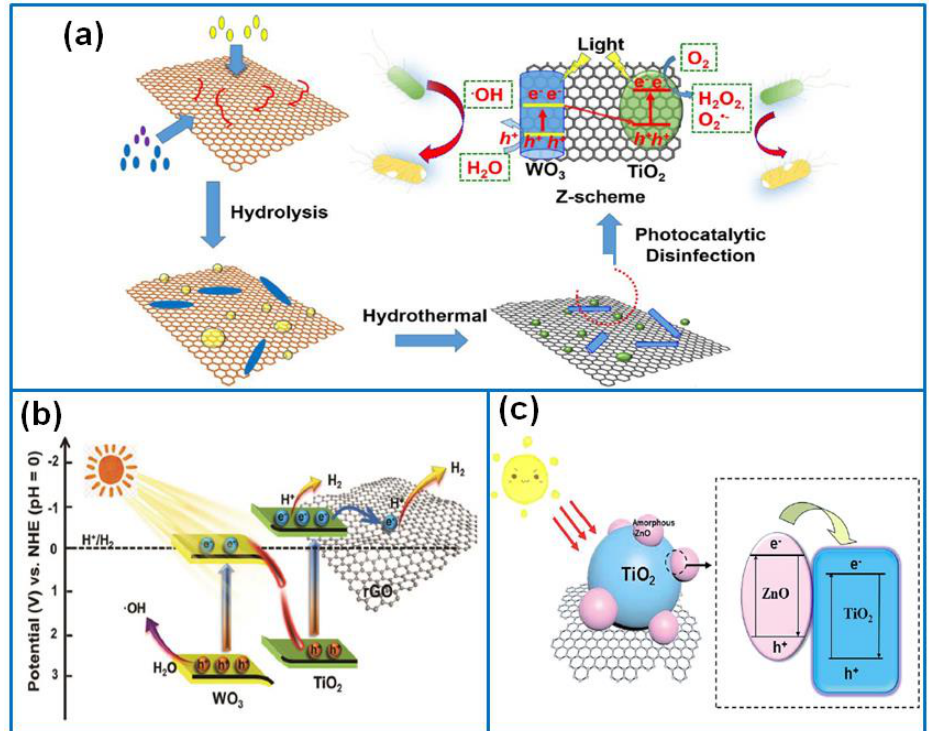
Figure 7. ( a ) Preparation of TiO 2 /rGO/WO 3 photocatalyst; produced with permission